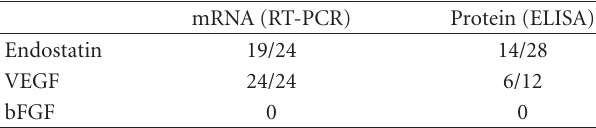
Table 2: Expression of endostatin, vascular endothelial growth factor (VEGF), and basic fibroblast growth factor (bFGF) by lymphoblasts (RT-PCR) in a group of 24 patients. The protein was measured by ELISA method in 28 patients and was expressed in half of the cases studied, for endostatin and VEGF. We found no expression of bFGF by the lymphoblasts, neither bFGF mRNA nor protein expression